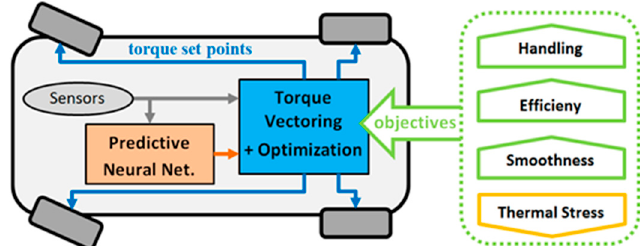
Figure 3. Diagram from the control system perspective representing the targeted vehicle with 4 electric motors, illustrating a simplified block diagram of the algorithms and highlighting its objectives for the application.